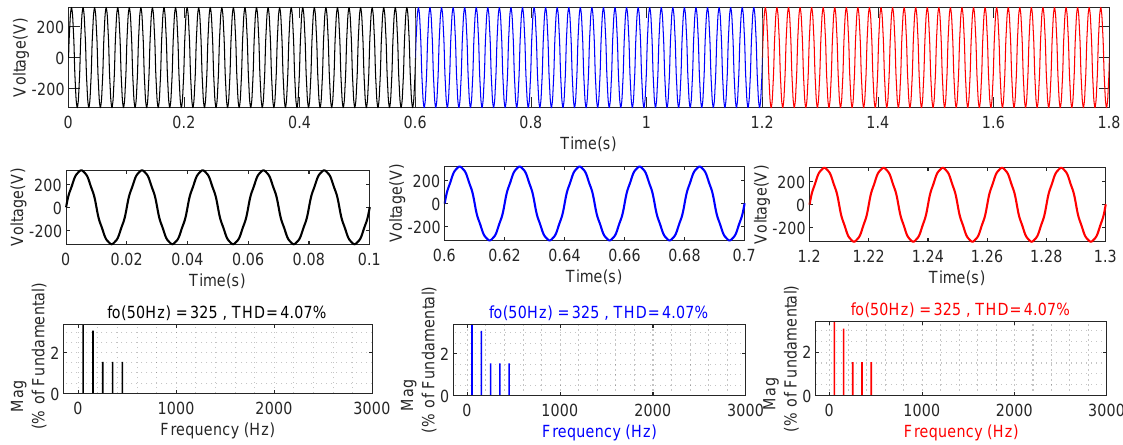
Figure 14. Distorted grid voltage V s used for testing of proposed